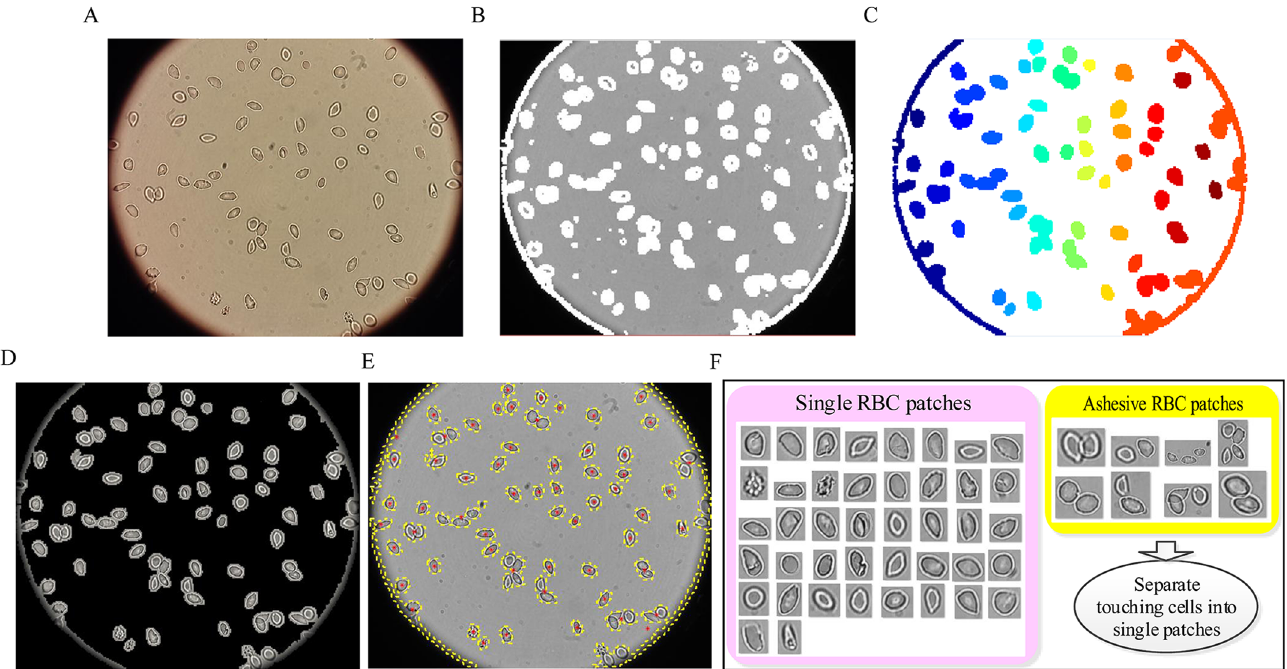
Fig 3. Determining ROIs and RBC patch extraction based on information from the entropy statistical estimation and morphology operations. (A) raw microscopy image. (B) Blocks with high entropy. (C) ROI mask image. (D) Detection of ROIs. (E) Boundaries of ROIs. (F) Single&